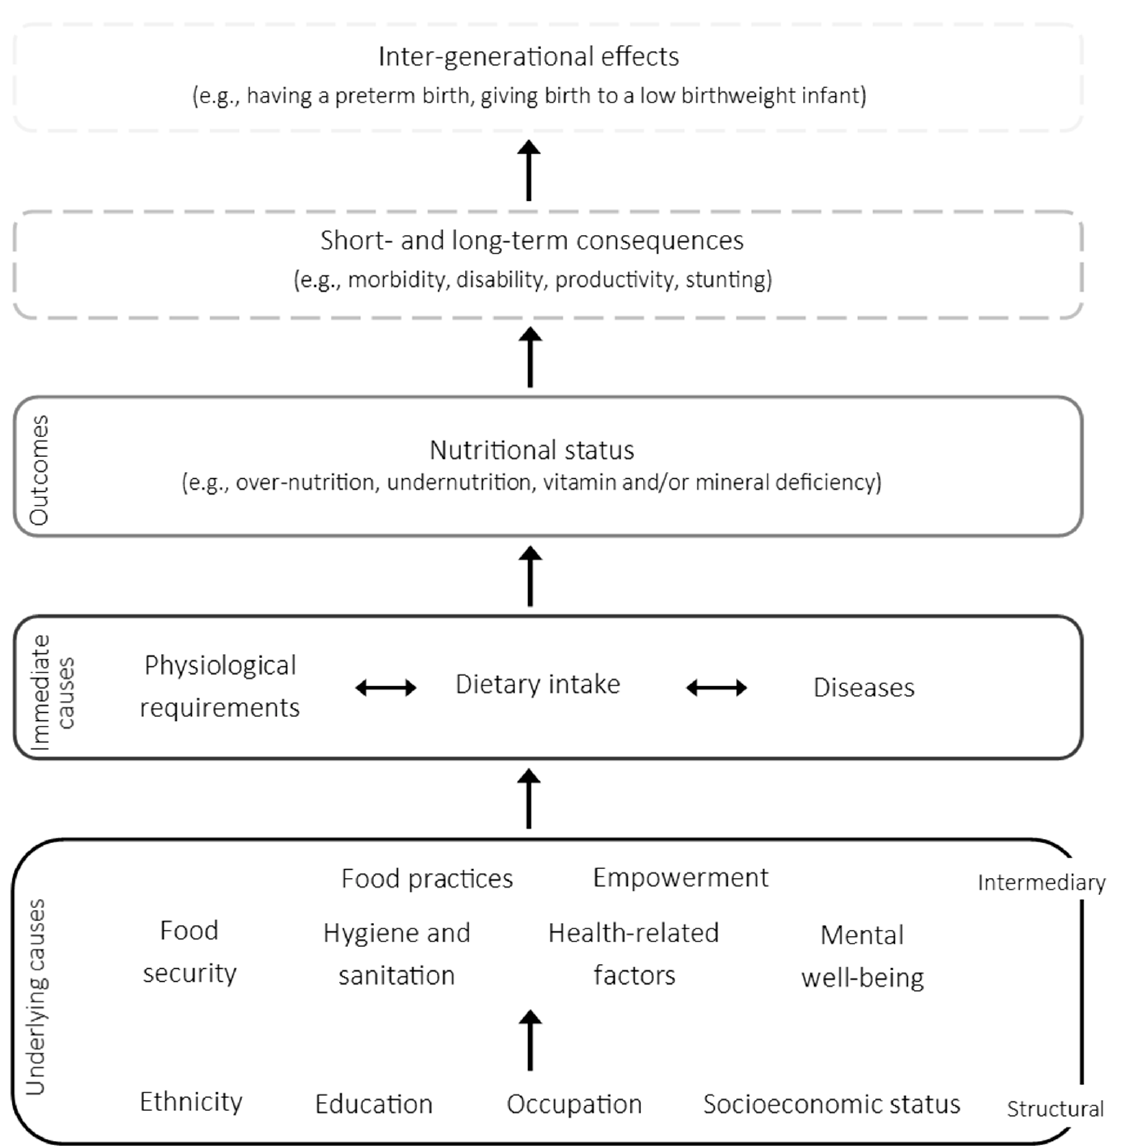
Figure 1. Conceptual framework of social determinants of health (SDoH) affecting the nutritional status of adolescent girls and their downstream sequelae.